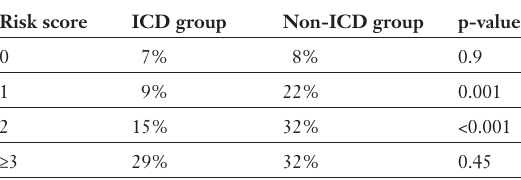
Mortality according to the MADIT-II risk score